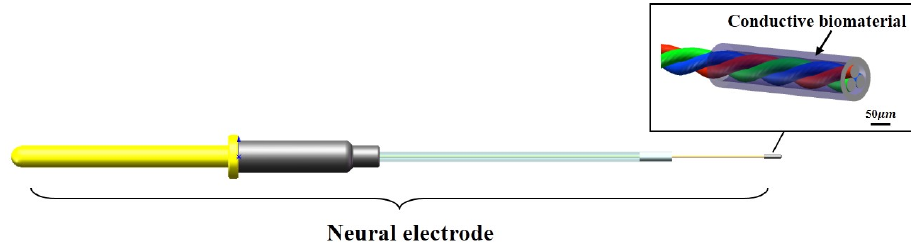
Figure 1. Low modulus bioelectrode design.